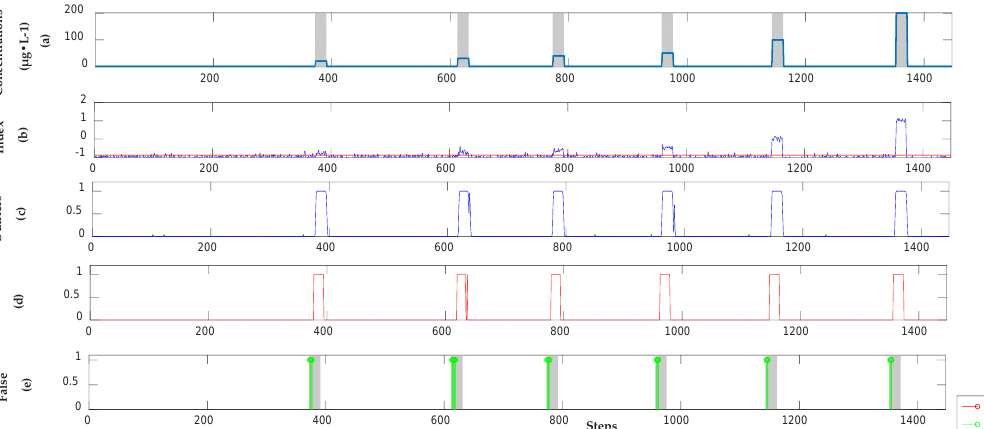
Figure 6. The detection results of hydroquinone in the semi-supervised model. ( a ) Location and concentration of each event; ( b ) Alarm signals, which exceeded the threshold shown as the red dotted line; ( c ) Outliers obtained by using SVR; ( d ) Alarm sequences triggered by Sequential Bayesian; ( e ) FP points and FN points compare with real categories.